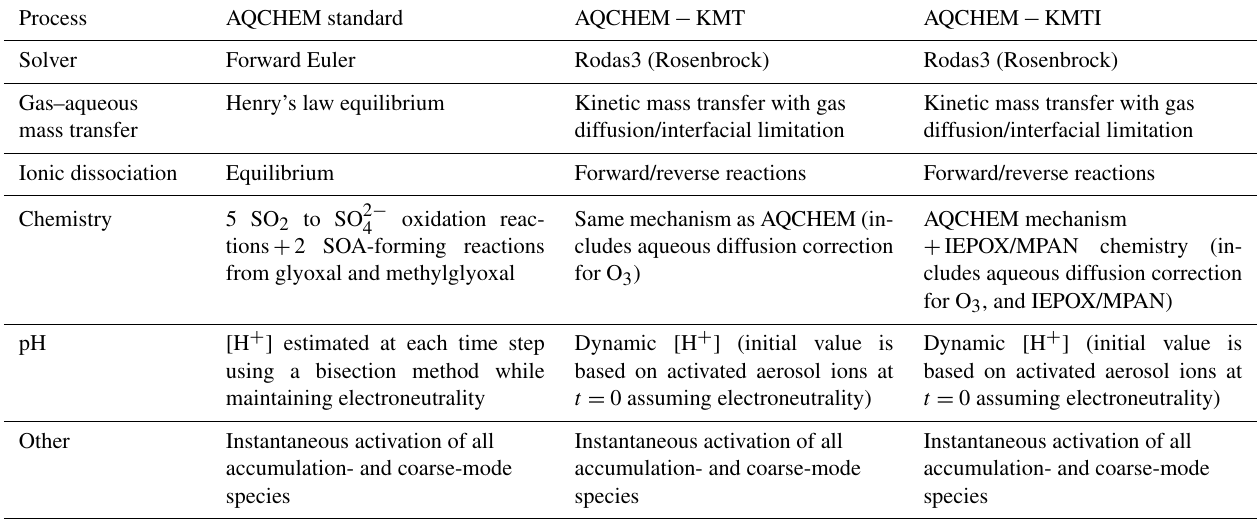
Table 1. Comparison of cloud chemistry models included in CMAQv5.1. Process AQCHEM standard AQCHEM − KMT AQCHEM − KMTI Solver Forward Euler Rodas3 (Rosenbrock) Rodas3 (Rosenbrock) Gas–aqueous Henry’s law equilibrium Kinetic mass transfer with gas Kinetic mass transfer with gas mass transfer diffusion/interfacial limitation diffusion/interfacial limitation Ionic dissociation Equilibrium Forward/reverse reactions Forward/reverse